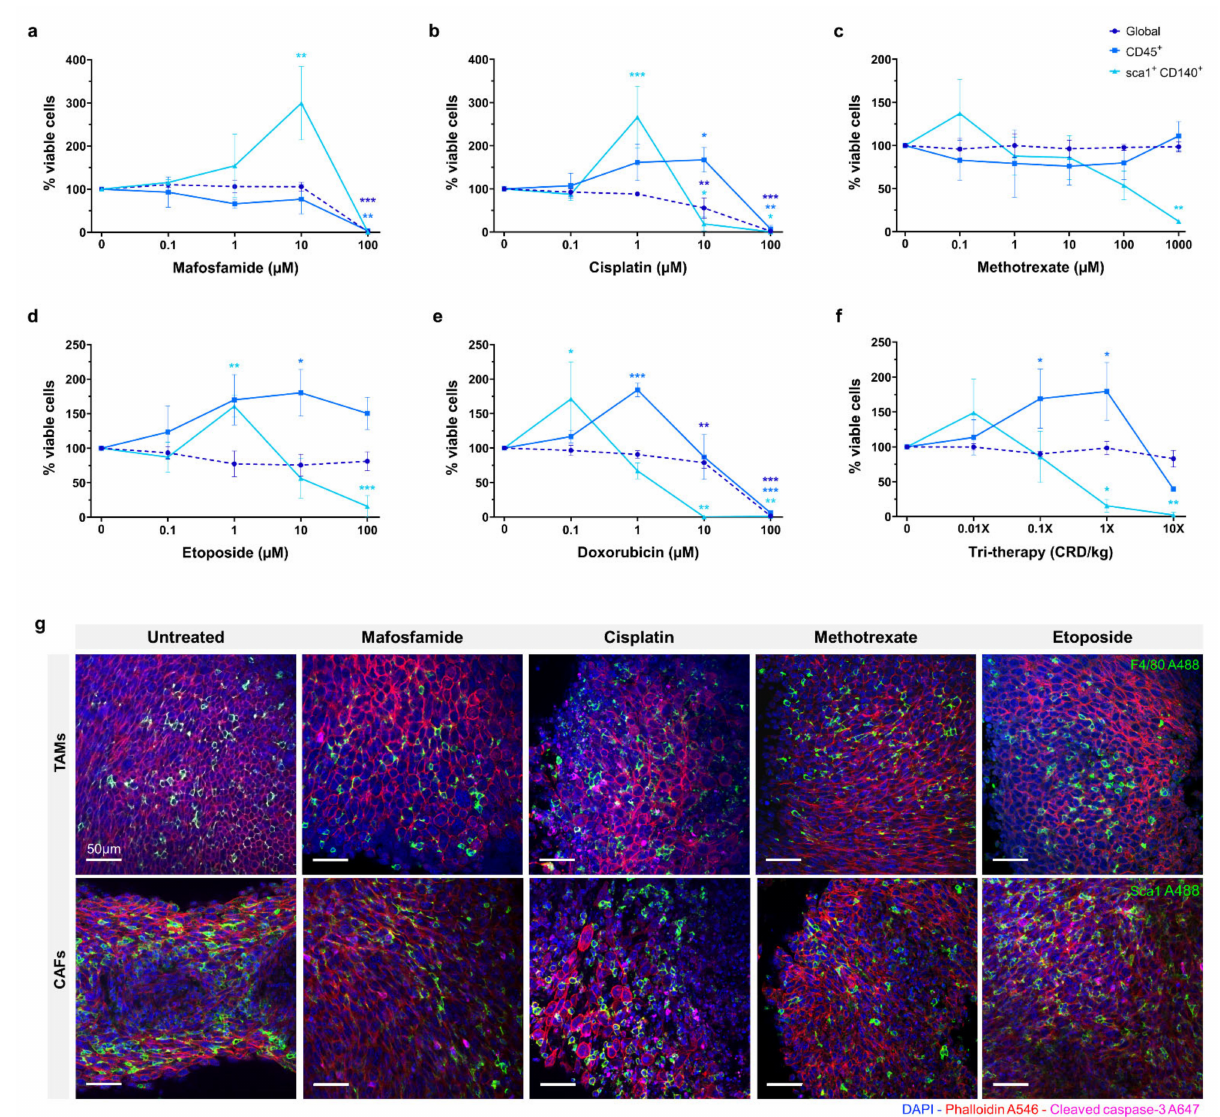
Figure 3. Effects of chemotherapy treatment on organotypic culture after 4 days. ( a – f ) Viability measured by flow cytometry assay after treatment with scalar doses of mafosfamide, cisplatin, methotrexate, etoposide, doxorubicin, and tri-therapy cocktail represented as % of untreated control. ( g ) Fluorescent images of 10 µ M drug-treated slices at day 4. Samples are stained for DAPI (nuclei, blue), phalloidin (F-actin, red), cleaved caspase-3 (apoptosis, pink), and F4/80 (macrophage marker, green) or sca1 (CAFs marker, green). Data is expressed as Mean ± SD of n = 3 samples. p -values; * p ≤ 0.05, ** p ≤ 0.01, *** p ≤